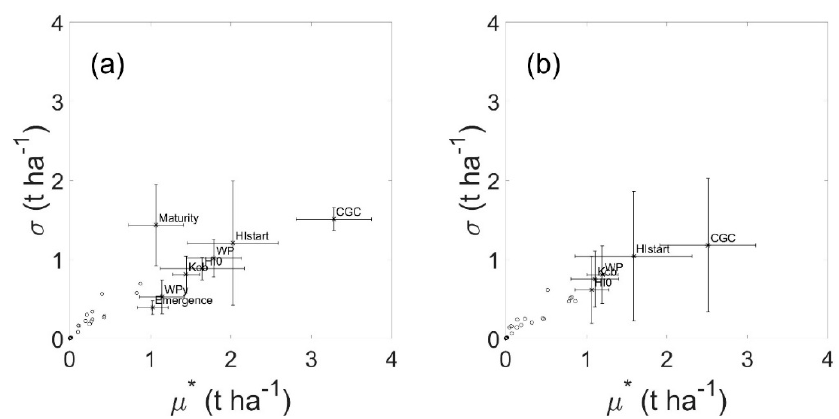
Figure 2. Morris method parameter screening results for (a) Maccarese and (b) Xiaotangshan test sites. Mean values of the Morris sensitivity indices μ * and s are indicated by markers, and the errors bars indicate the standard deviation of index values across all the years. Only parameters with a μ * value higher than 1 t ha − 1 are labeled. The meanings of parameter labels are reported in Table 1.